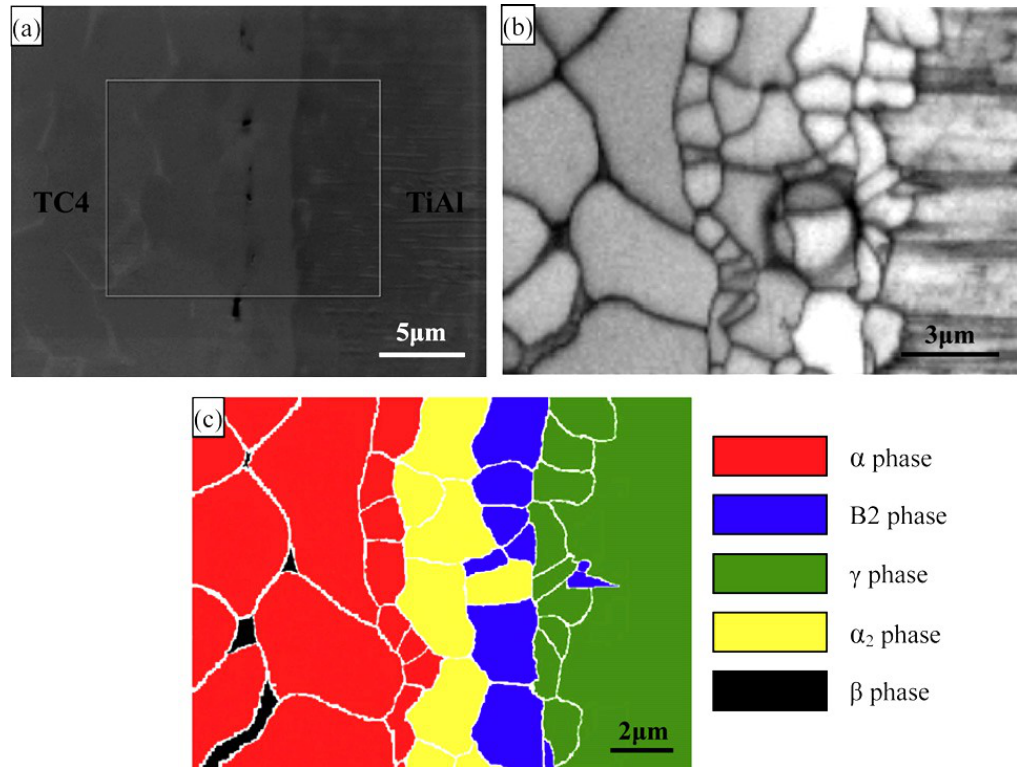
Figure 9. ( a ) Electron backscatter diffraction (EBSD) analysis field of the as-prepared